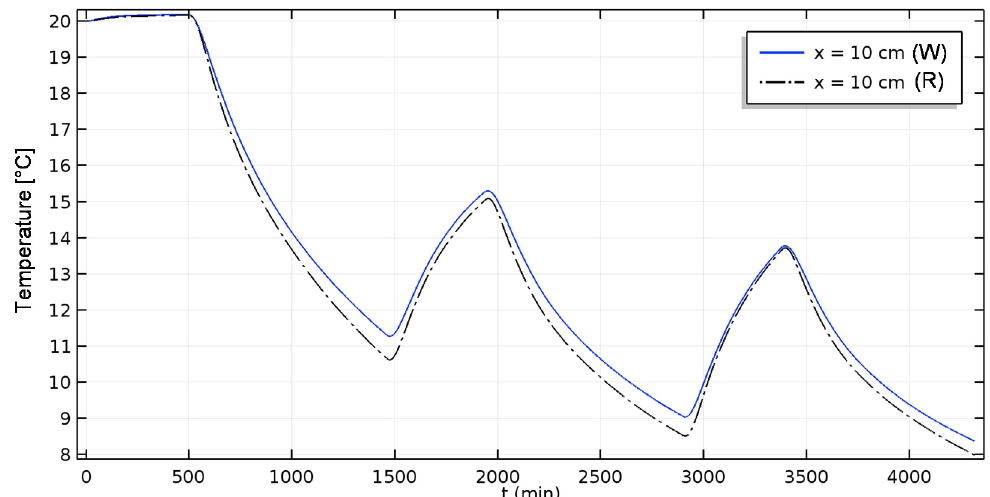
Figure 13. Non-isothermal case: Temperature evolution of aged and reference hemp concrete over time (W: Weathered; R: Reference).